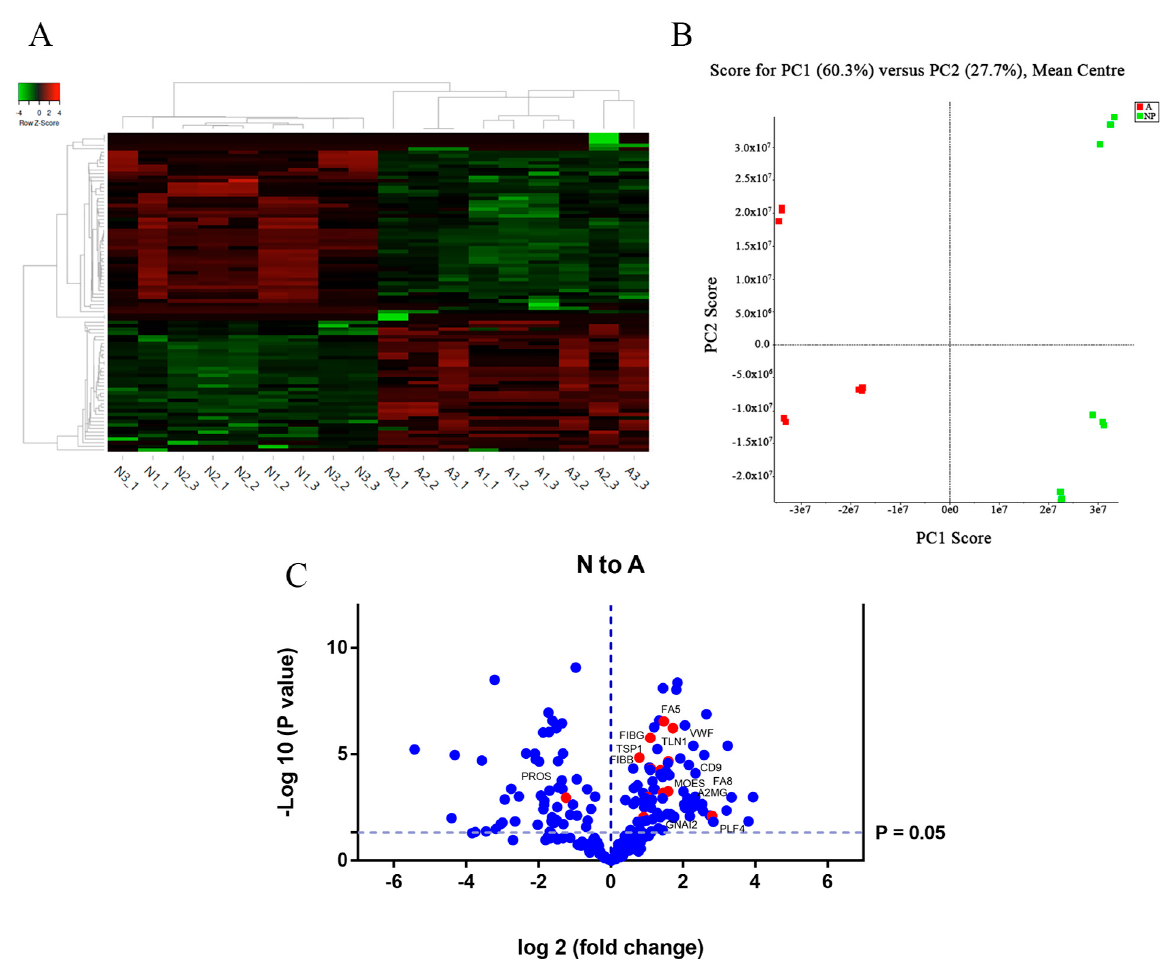
Figure 3. Unsupervised analysis of differentially expressed proteins in plasma exosomes from neonates vs. adults by SWATH MS. ( A ) Heat map showing hierarchical clustering between adult and neonate exosomes using top 50 differentially expressed proteins. Analysis was carried out in 3 pool samples, each consisting of pooled plasma exosomes from 2 newborns or 2 adults. ( B ) PCA analysis showing separation of adult (red) and neonate (green) exosome samples. ( C ) Volcano diagram resulting from comparison of newborn and adult exosomes. Proteins are separated according to the log 2 of the FCh ( x -axis) and the − log 10 of the p -values based on a two-tailed t -test ( y